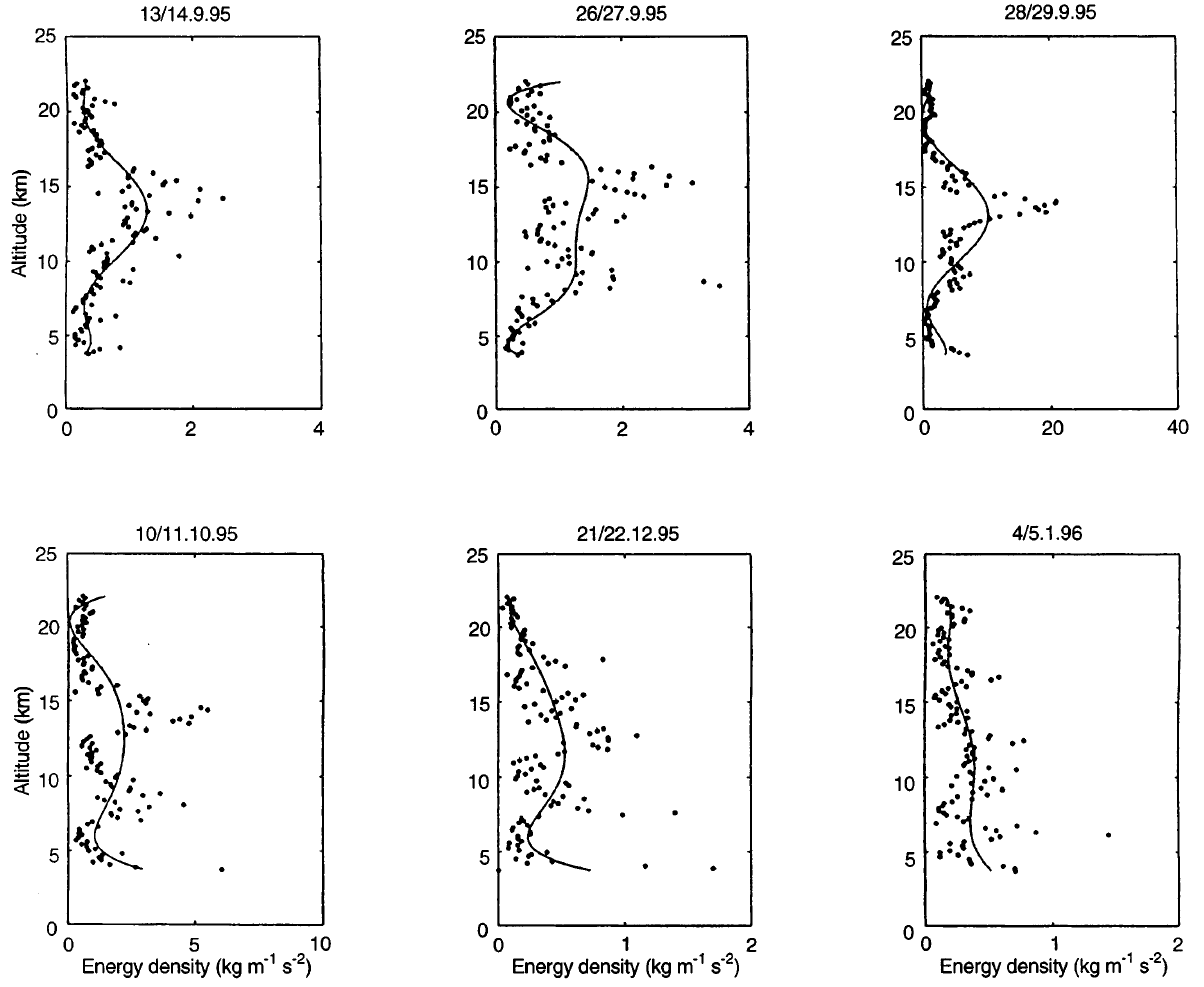
Fig. 6. Height variations of energy densities ( q